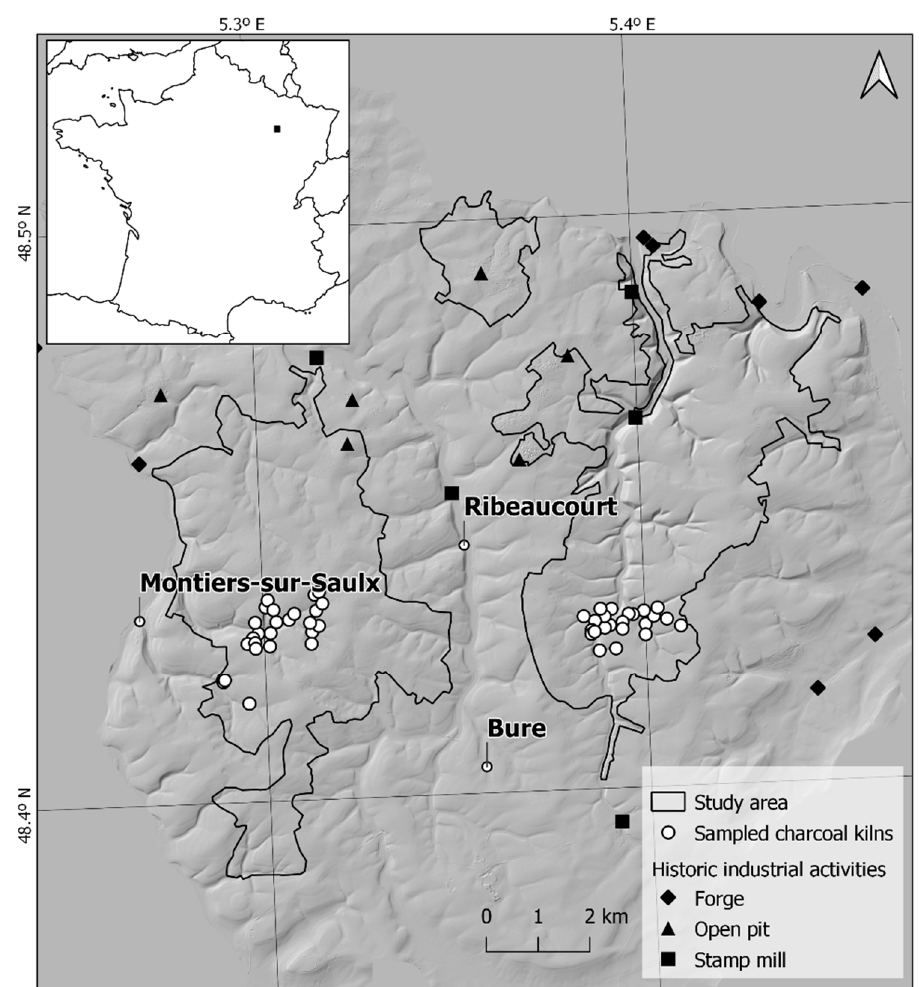
Figure 1. Location of the study area in mainland France (square). The study area on a LiDAR-derived hillshade image is outlined by a full black line (corresponding to woodlands), and the sampling points for charcoal analysis and reference to historic industrial activities (forges, open pits for ore extraction and stamp mills) are indicated.